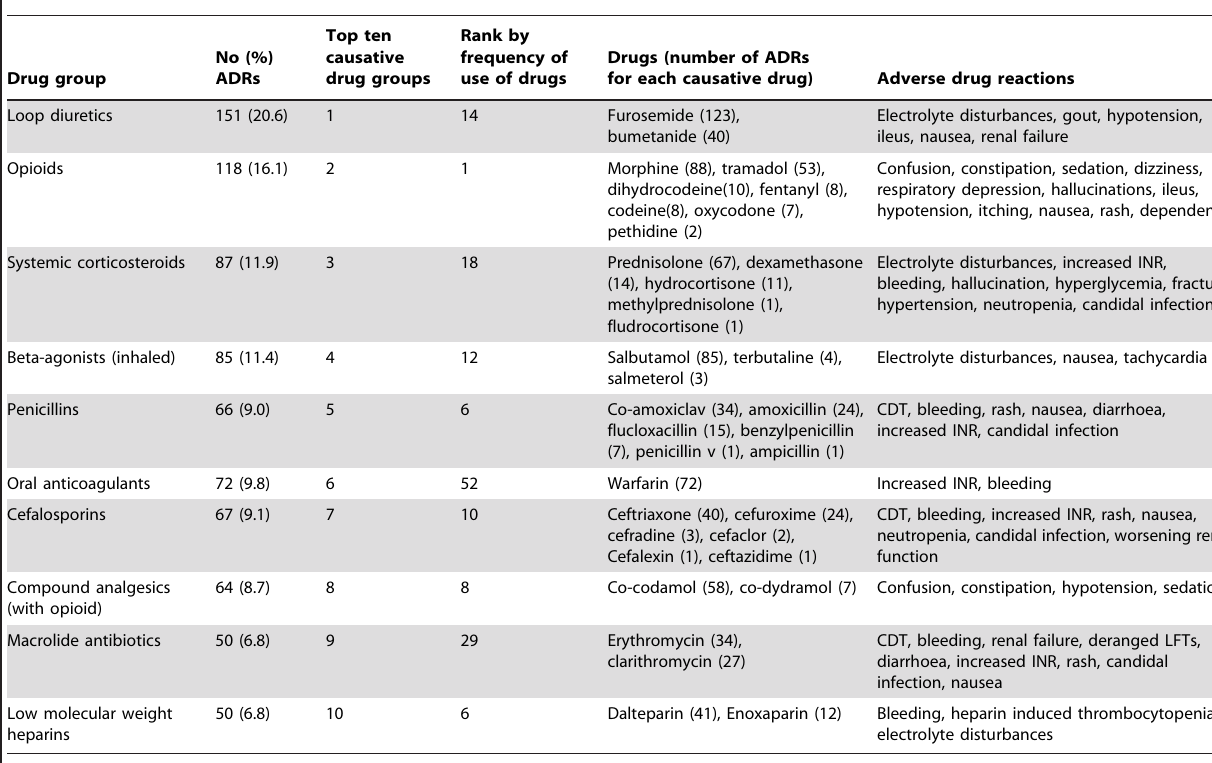
Table 5. Drugs most frequently implicated in causing the adverse drug reactions (ADRs).